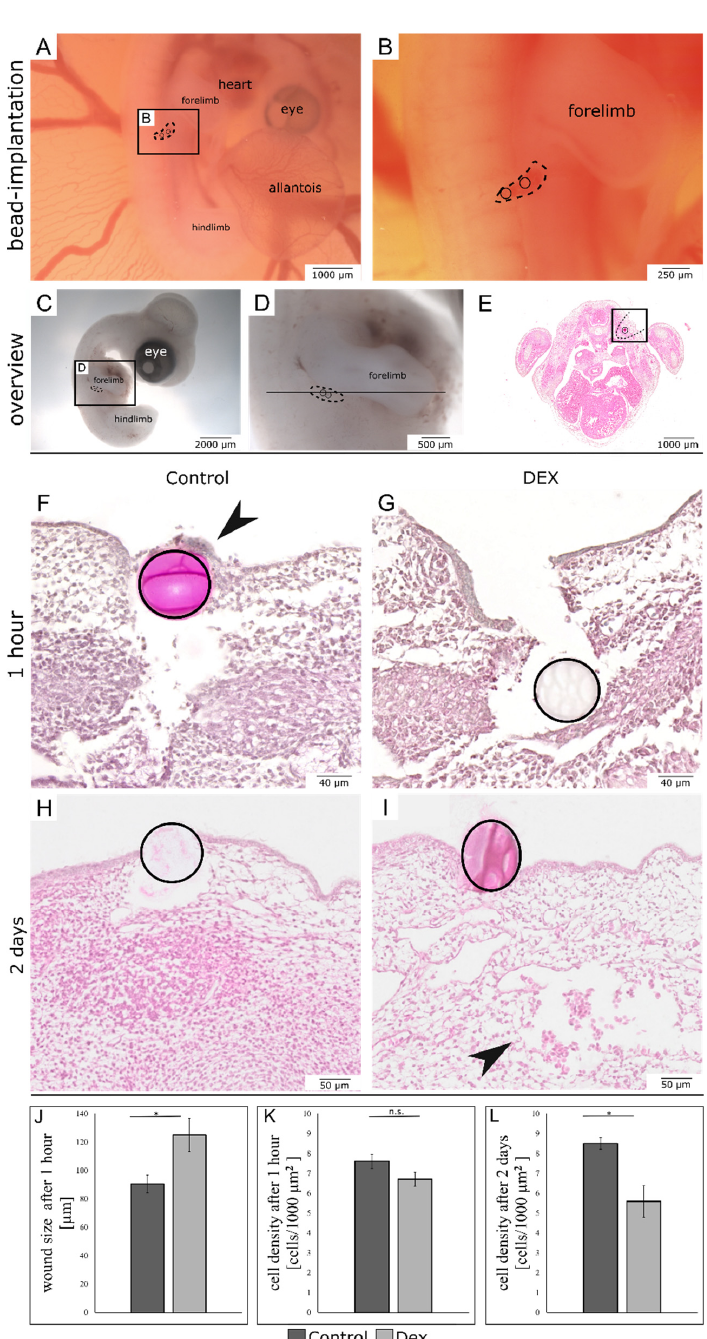
Figure 1. Overview of bead-implanted wounds. The images ( A , B ) display the method of in-ovo bead implantation in embryonic skin incisional wounds. The wound margins are indicated by dotted lines. ( C , D ) show macroscopic images of an exemplary embryo two days after wounding for orientation purposes. The line in ( D ) indicates the sectioning level. ( E ) shows an overview of an exemplary histological section, in which the wound area is indicated by a black square. ( F ) shows a control wound after one hour. ( G ) shows a dex wound after one hour. Note the impaired re- epithelialization in the dex wound in comparison to the regenerating epithelium in the control wound (( F ), arrowhead). ( H ) shows a control wound after two days. ( I ) shows a dex wound after two days. Note the mesenchymal defects, blood infiltrations, and reduced cell density in the dex wound (( I ), arrowhead). ( J – L ) show the quantification of different wound parameters. Data are presented as mean ± SE (control: n = 4; dex: n = 5 for both time points) * p < 0.05. n .s. = not